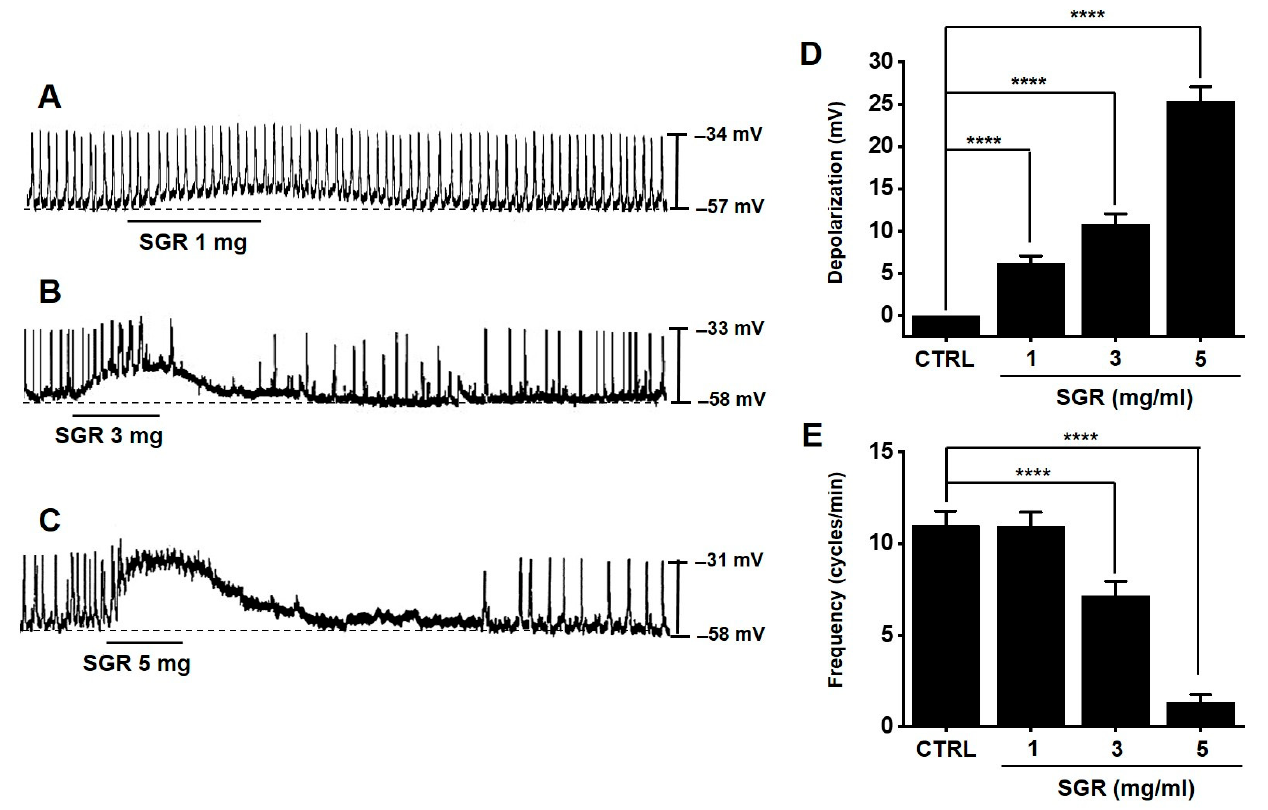
Figure 6. Effects of SGR extract on pacemaker activity of ICC. ( A – C ) SGR depolarized the ICC pace- maker activity; ( D ) the depolarization changes; ( E ) the frequency changes. CTRL ( n = 12). SGR 1 mg ( n = 12). SGR 3 mg ( n = 12). SGR 5 mg ( n = 12). Bars represent mean ± standard error. **** p < 0.0001. CTRL: Control. SGR: Smilacis Glabrae Rhixoma . ICC: interstitial cells of Cajal.